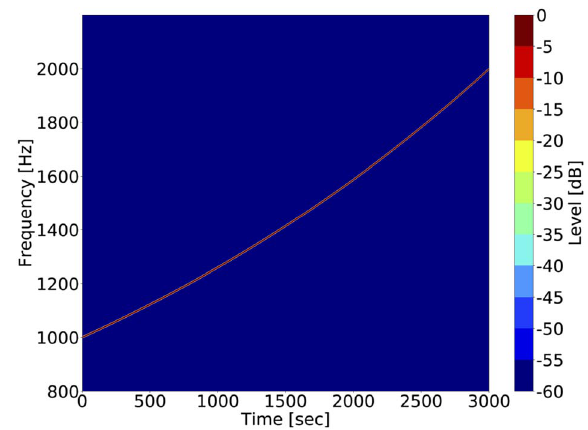
Figure 7. Spectrogram of the input piston velocity signal n 0 ð t Þ , consisting of a chirp in the range [ f a , f b ] and a low-frequency tone f 0 (not visible here).